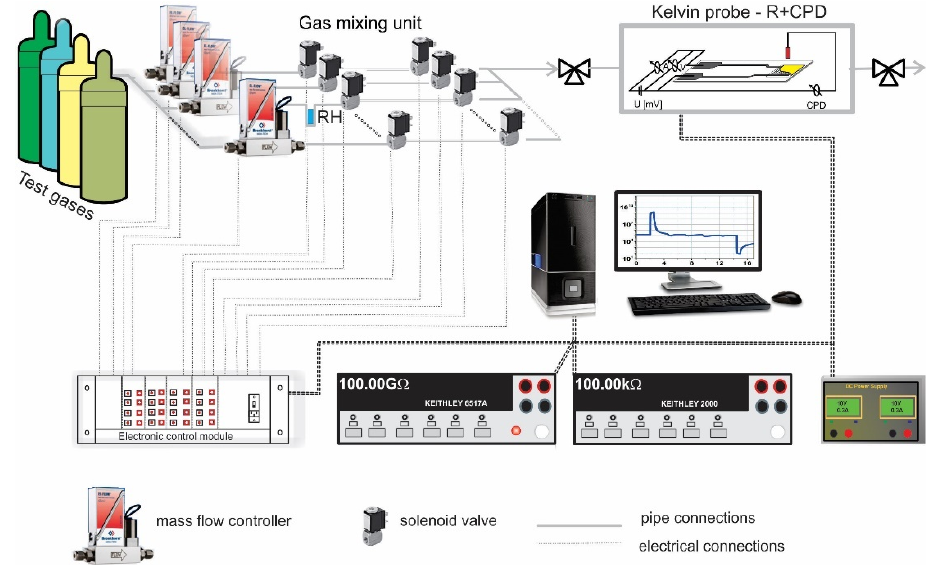
Figure 1 . Schematic picture of the Gas Mixing Station used during the gas sensing